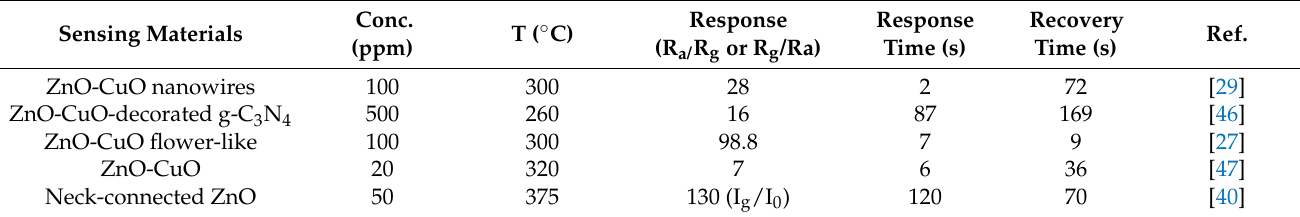
Table 1. Comparison between ethanol gas sensing response of optimized gas sensor in this study and those reported in the